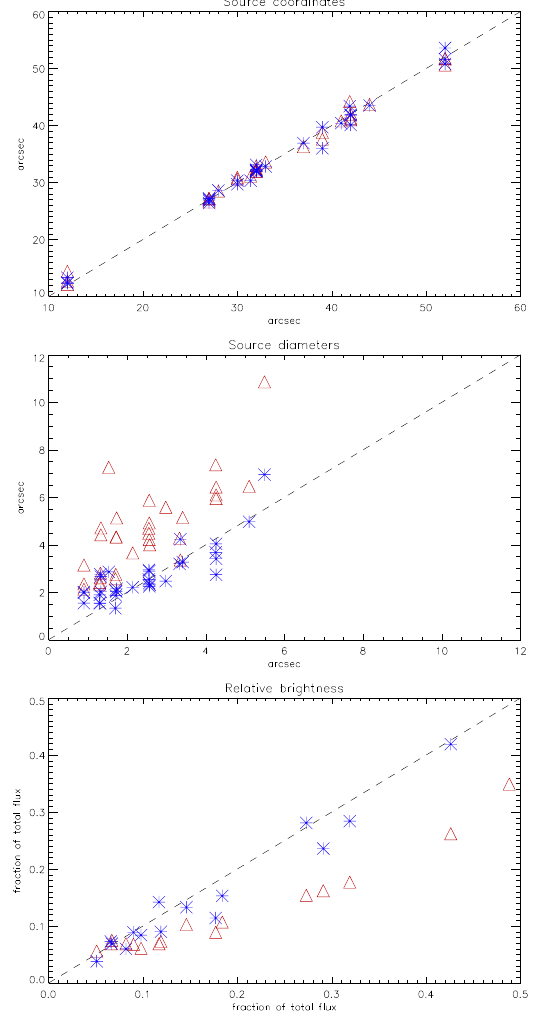
Figure 10. The plots present parameters collected in the Table 1. Red triangles represents results from CLEAN-Vis, and blue asterisks are for RL algorithm (see text for further